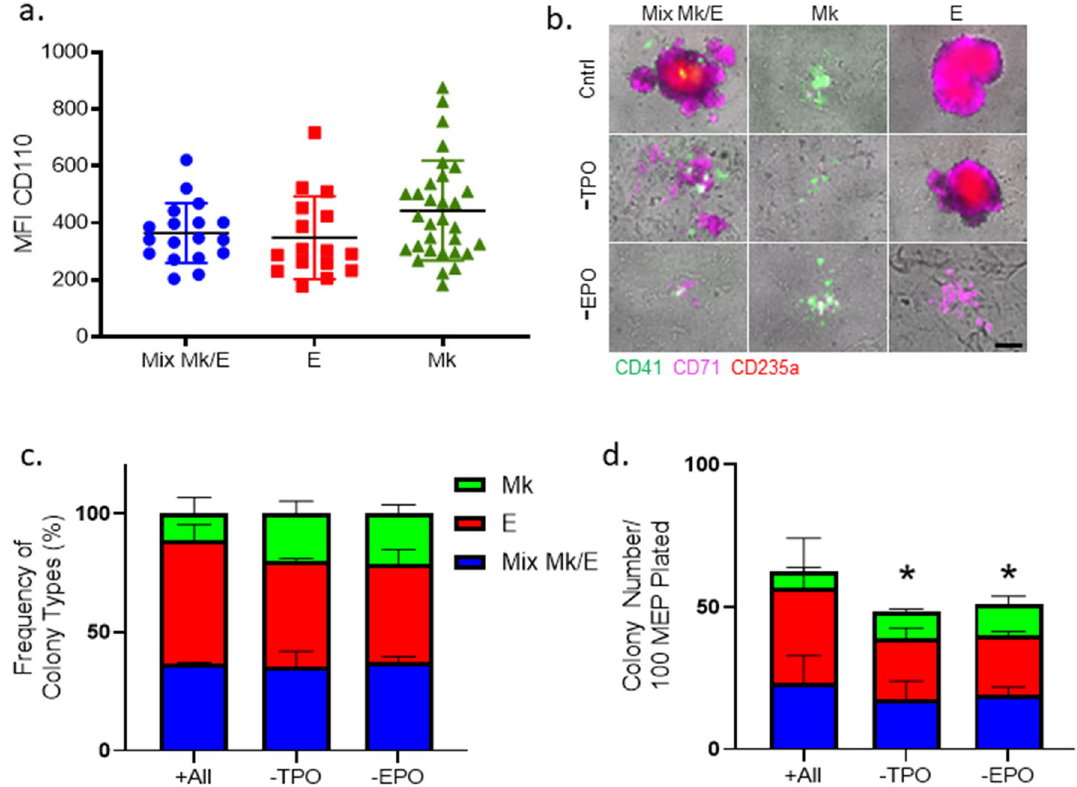
Figure 5. Thrombopoietin and erythropoietin do not instruct MEP lineage commitment. ( a ) Index sorting and analysis of TPO receptor, c-Mpl (CD110). MEPs were index sorted into 96-well plates and grown in CFU assay conditions for 14 days. Colony type outcome was correlated with expression of CD110 at the time of sorting/plating. n = 66. Mean and SD indicated. ( b ) Representative colonies grown from individual MEPs in control, -TPO, and -EPO conditions. Mk/E mix, E-only, and Mk-only colonies were observed in control, -TPO, and -EPO CFU conditions at 14 days. Cells within the colony were stained in situ with CD41 (green), CD71 (magenta), and CD235a (red). Scale bar = 250 μm. ( c ) Frequency of colony types observed in control, -TPO, and -EPO CFU assays. Colony counts (Mk/E mix in blue, E-only in red, and Mk-only in green) were normalized to total colonies grown in control, -TPO, and -EPO conditions. n = 4. Mean and SD indicated. ( d ) Colony counts of MEPs grown in control, -TPO, and -EPO CFU assays. Colony counts (Mk/E mix in blue, E-only in red, and Mk-only in green) are reported out of 100 plated MEPs grown in control, -TPO, or -EPO CFU conditions. n = 4, *p < 0.05. Mean and SD